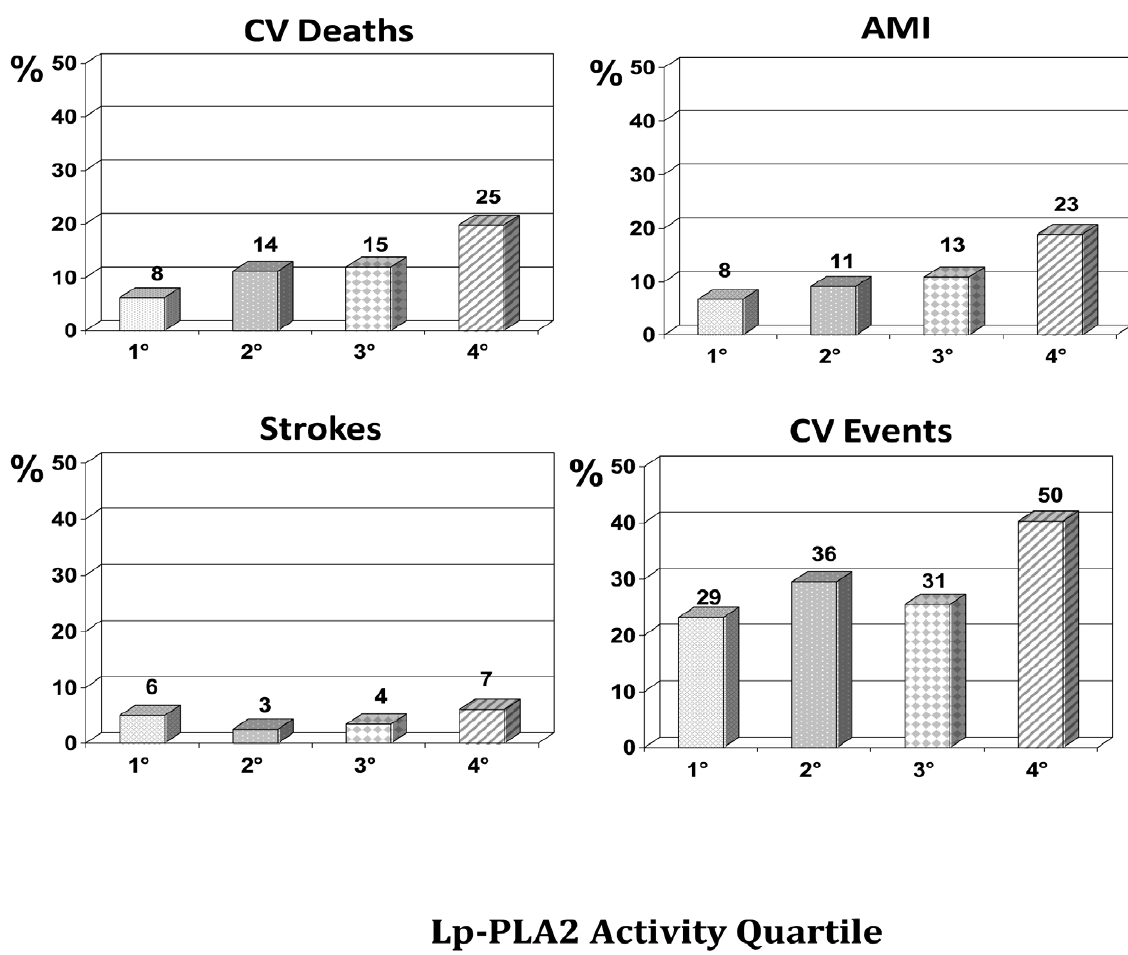
Figure 3. Cardiovascular events by Lp-PLA2 activity. The bar graphs show cardiovascular death and events rate by quartiles of Lp-PLA2 activity (the absolute number of events is shown above each column). Cardiovascular deaths (p=0.012), events (p=0.016), acute myocardial infarction (AMI) (p=0.019) were significantly different across Lp-PLA2 activity quartiles.